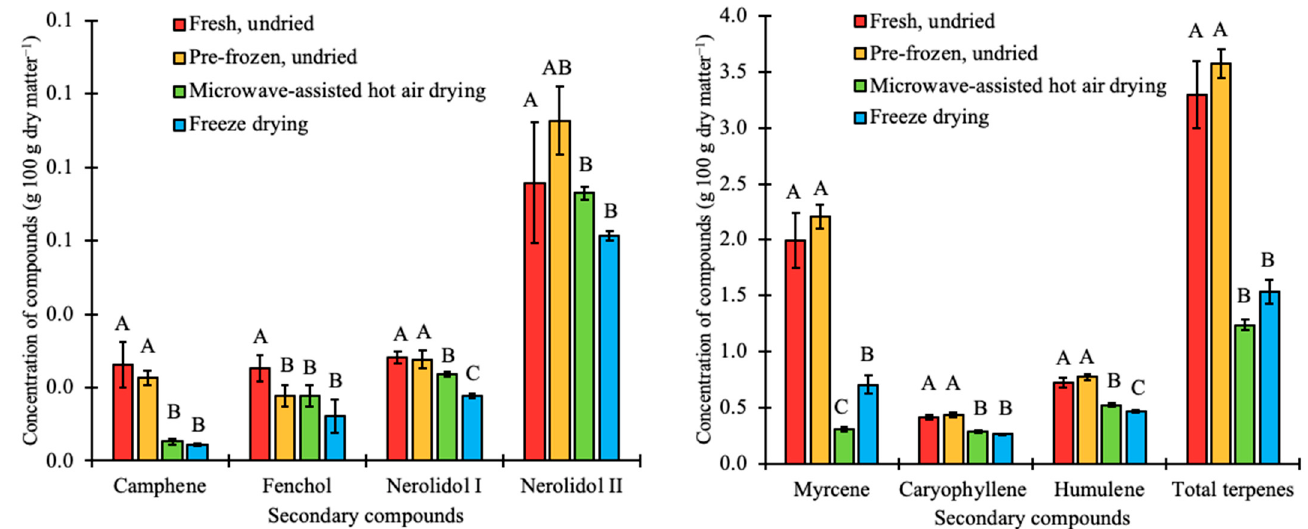
Figure 6. Concentration of terpenes in hops in fresh undried, pre-frozen undried, microwave-assisted hot air dried, and freeze-dried hops ( H. lupulus ) biomass. Bars with the same letter are not significantly ( p < 0.05) different.